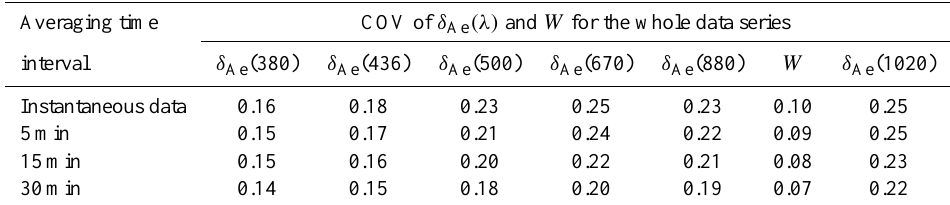
Table 2. Mean coefficient of variation (COV) of δ Ae (λ) and W at different averaging time intervals for the whole data series obtained by star photometer EXCALIBUR. Averaging time COV of δ Ae (λ) and W for the whole data series interval δ Ae (380) δ Ae (436) δ Ae (500) δ Ae (670) δ Ae (880) W δ Ae (1020) Instantaneous data 0.16 0.18 0.23 0.25 0.23 0.10 0.25 5min 0.15 0.17 0.21 0.24 0.22 15min 0.15 0.16 30min 0.14